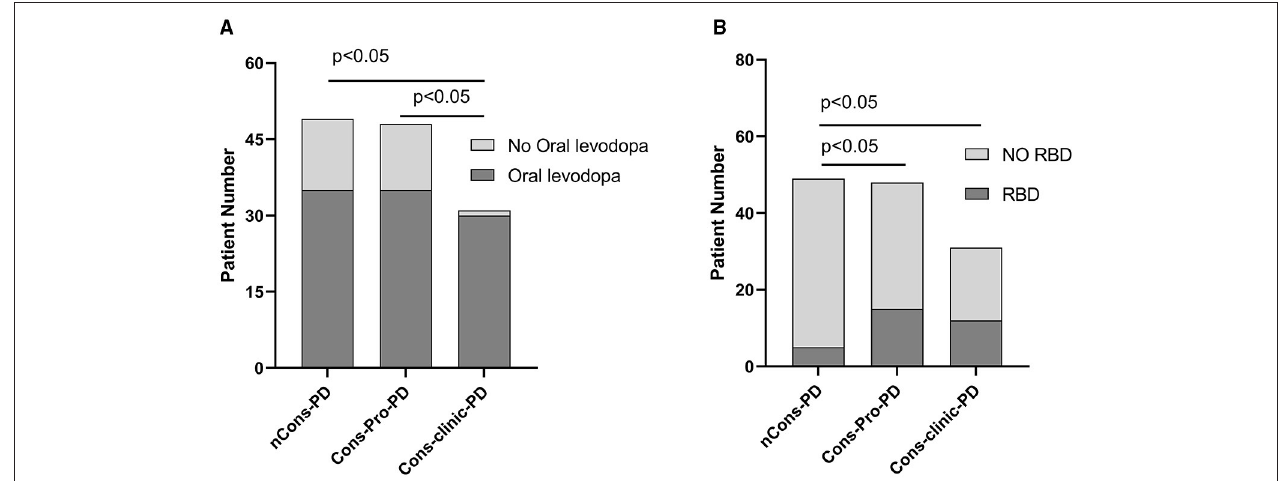
FIGURE 4 | (A) Reveals that 96.8% of individuals in the Cons-clinic-PD group use levodopa, which is higher than 72.9% ( p < 0.05) in the Cons-Pro-PD group and 71.4% ( p < 0.05) in the nCons-PD group, with no substantial difference ( p > 0.05) between the Cons-Pro-PD group (72.9%) and the nCons-PD group (71.4%). (B) Indicates that 10.2% of people in nCons-PD have RBD, which is lower than 31.3% ( p < 0.05) in Cons-Pro-PD and 38.7% ( p < 0.05) in Cons-clinic-PD, but there is no statistical difference between 31.3% in Cons-Pro-PD and 38.7% ( p > 0.05) in